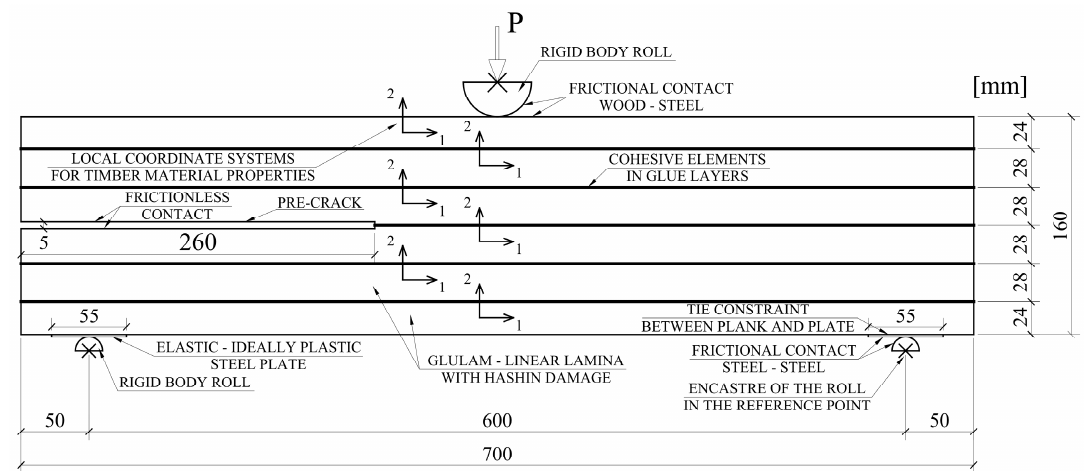
Figure 9. Finite elements method (FEM) model detailed description.